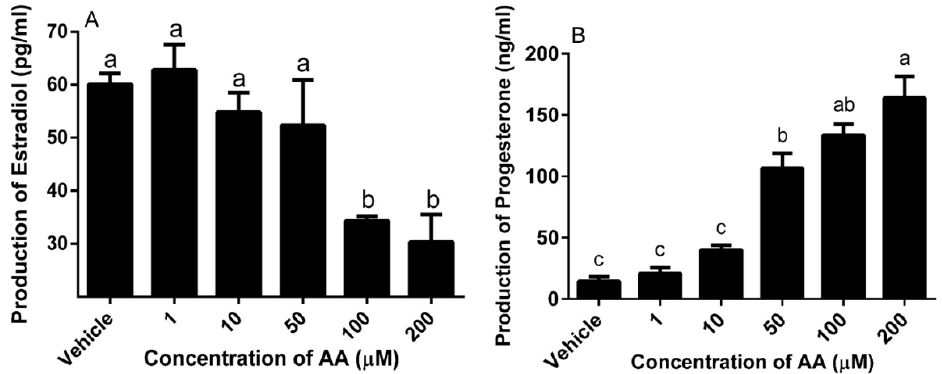
Figure 4. Effects of AA on the secretion of estradiol ( A ) and progesterone ( B ) in granulosa cells. Cells were challenged on Day 3 of culture with the given doses of AA for 24 h. Data are means ± SEM of three independent replicates. For each treatment, means without common letters are significantly different ( p < 0.05).